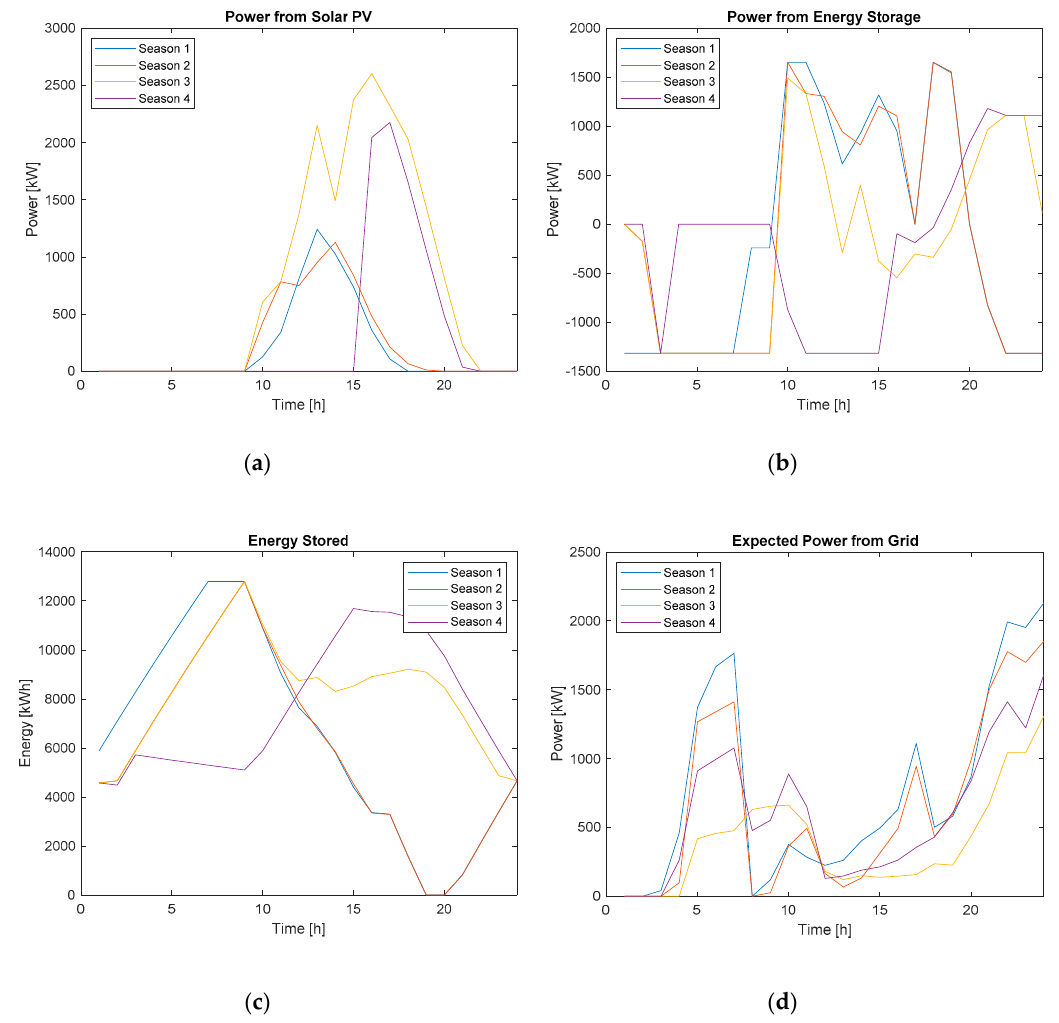
Figure 7. ( a ) Solar PV power from a 4124.57 kW system for one scenario; ( b ) power from energy storage for solar PV, energy storage, and grid power case for one scenario; ( c ) energy stored for solar PV, energy storage, and grid power case for one scenario; ( d ) expected power from the grid for solar PV, energy storage, and grid power case.